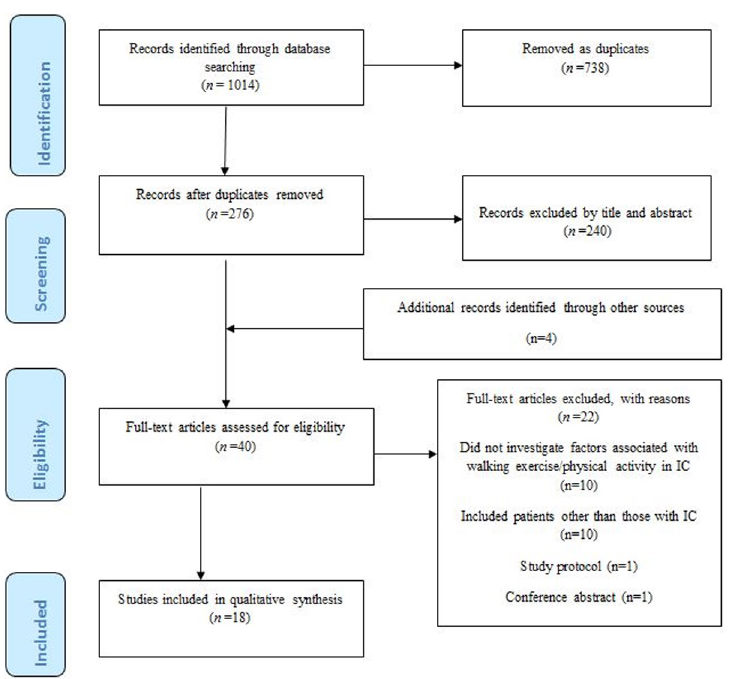
Fig 1. PRISMA flow diagram for systematic review of barriers and enablers to walking in individuals with intermittent